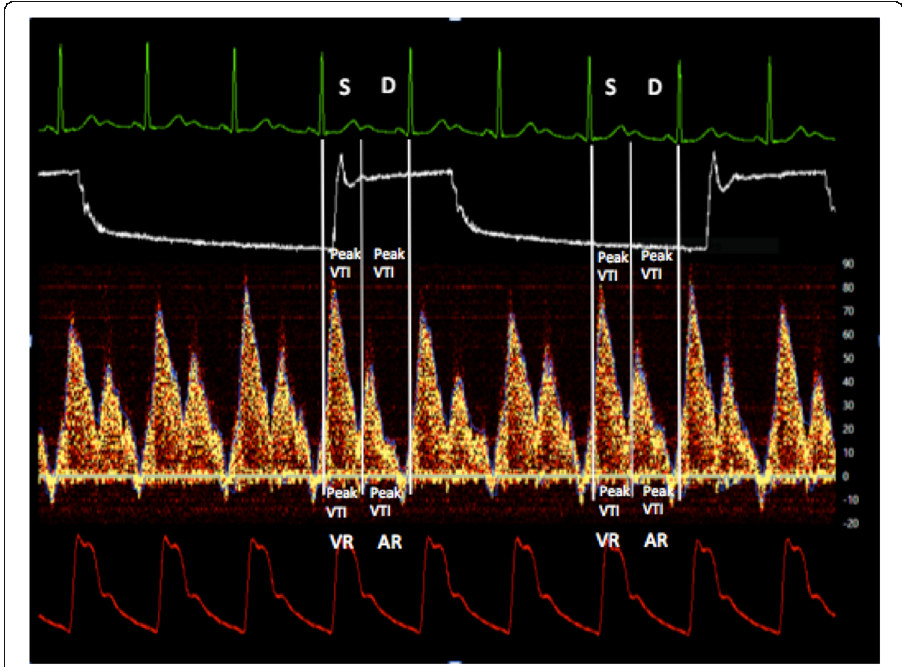
Fig. 1 Screenshot from Doppler analyzer with ECG, airway pressures, flow in SVC, and blood pressure tracings. Shown are, from upper side to lower side, ECG, airway pressure, Doppler flow signal from the SVC, and arterial blood pressure. S systolic forward flow, D diastolic forward flow, VR systolic reversal flow,